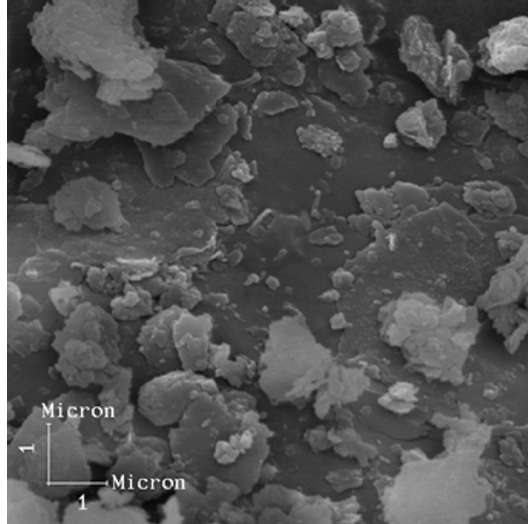
Figure 3. SEM micrograph of the clay fraction (10.000